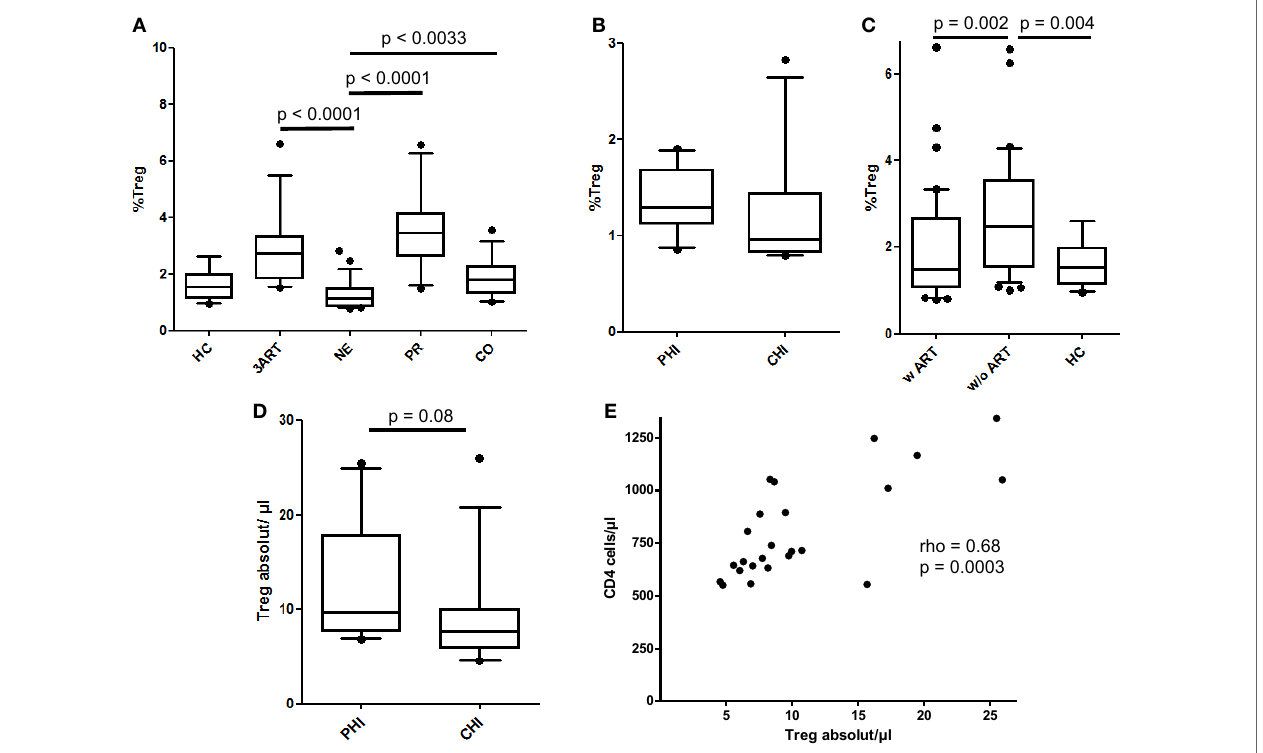
FigUre 4 | Relative frequencies and absolute cell counts of regulatory T cells (Tregs). (a) The New Era (NE) group showed the significantly lowest Treg frequencies compared with all the other HIV-infected groups ( p < 0.0033). (B) Comparable frequencies in the subgroups primary HIV infection (PHI) and chronic HIV infection (CHI) ( p = 0.11). (c) As already shown in the regulatory B cells, the relative Treg levels in the patients with antiretroviral therapy (w ART) were significantly decreased compared with those w/o ART ( p = 0.002) and were similar to the HIV-uninfected controls (HC) group. (D) There was a trend of a higher absolute Treg number in the PHI subgroup than in CHI subgroup ( p = 0.08). (e) The absolute Treg cell count in the NE group significantly correlated with the CD4 cell counts (rho = 0.68, p = 0.0003) [HC: n = 14; 3ART: n = 15; NE: n = 24 (PHI: n = 10; CHI: n = 14); progressors (PR): n = 18; CO: n =